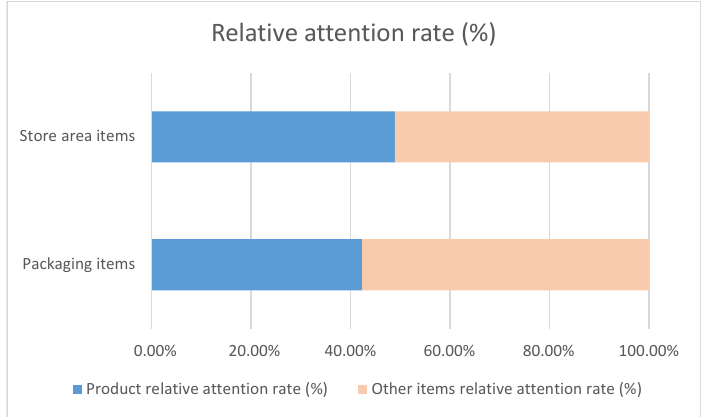
Figure 5. Attention rate (%) dedicated to the product, relative to other elements, for both packaging and store area. Source: Prepared by the authors.